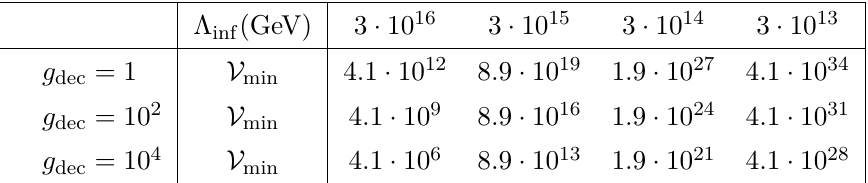
√ α 0 ) 6 ) in LVS as a function of the